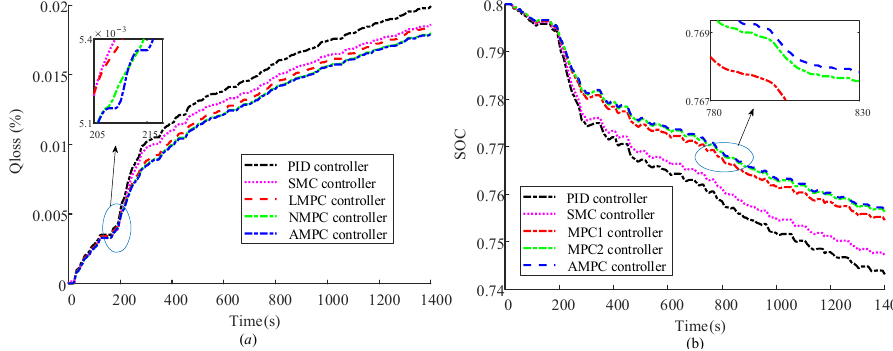
Figure 16. Under UDDS working conditions, the battery (SOHini = 1) parameters under the action of each controller: ( a ) battery capacity loss ( b ) SOC. Table 9. Capacity loss value and the SOC of the battery under each controller after UDDS cycle (SOHini = 1).